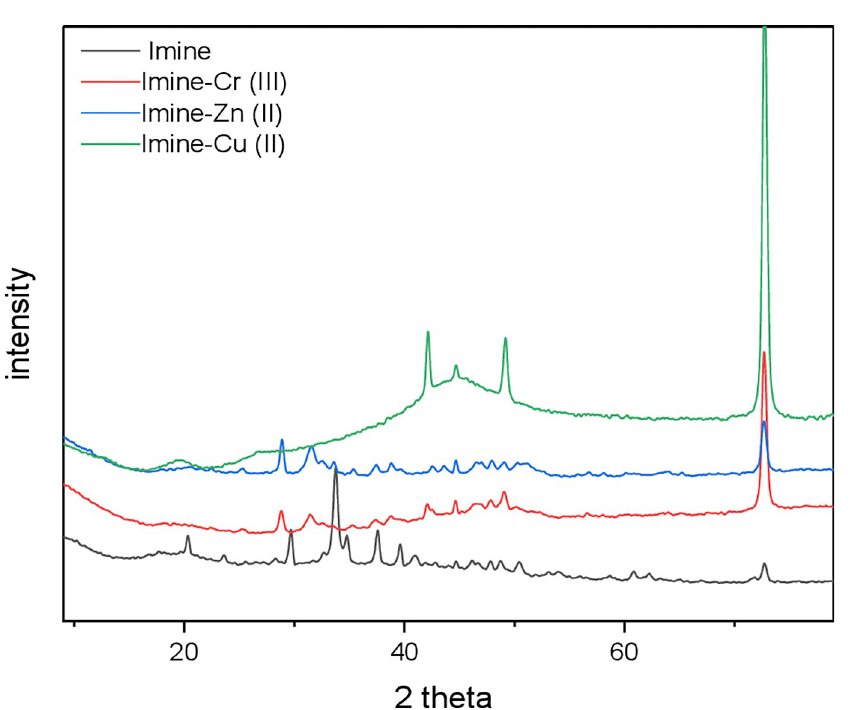
Fig 5. XRD spectra of Imine before and after Cu(II), Zn(II), and Cr(III)